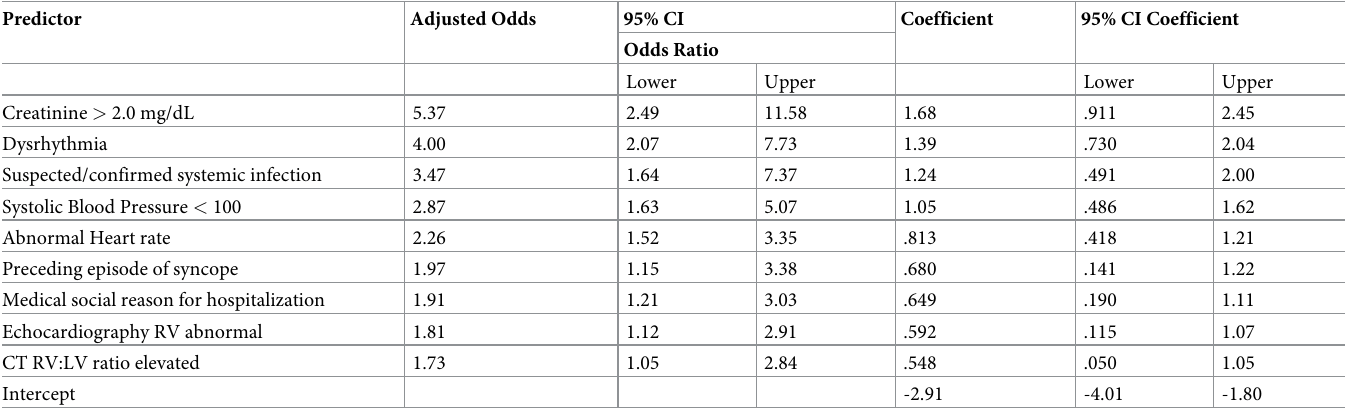
Table 2. Final variables of logistic regression